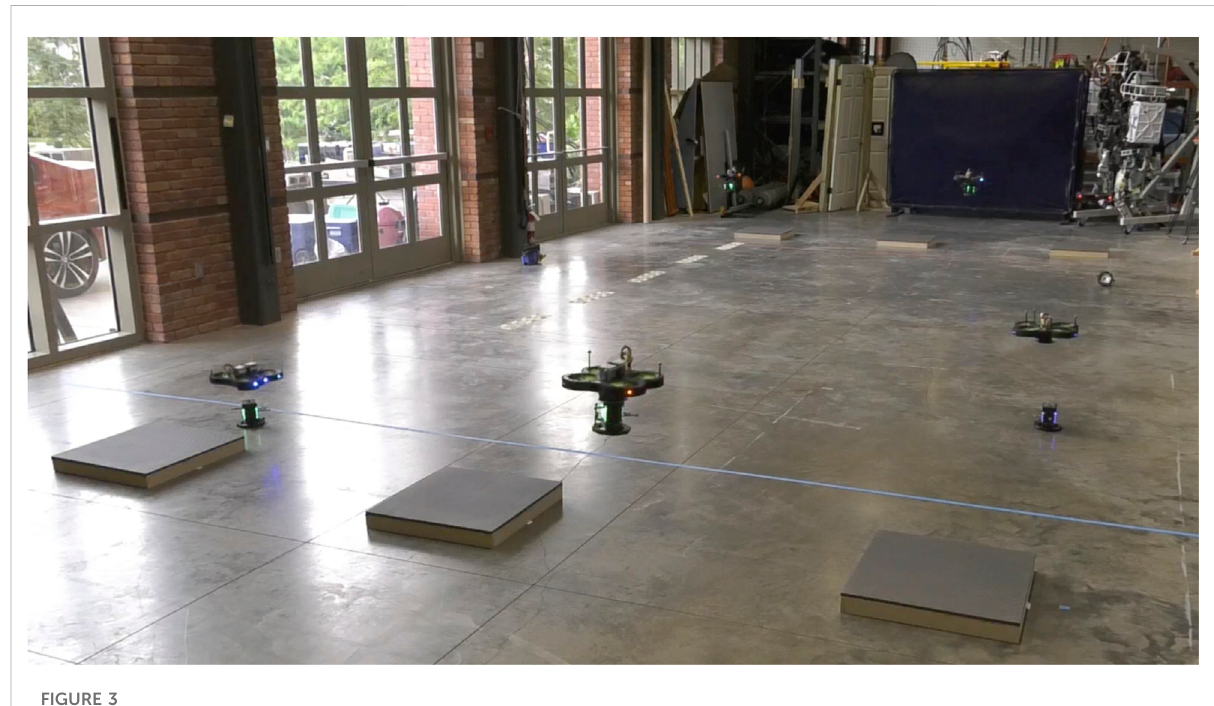
FIGURE 3 Live game of Capture-the-Flag in the lab